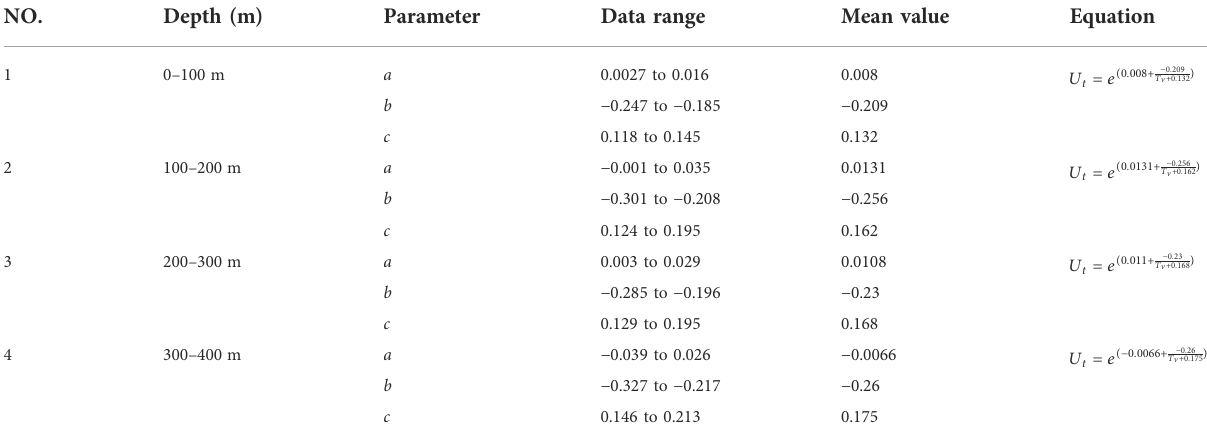
TABLE 3 The estimated parameters a , b and c for the CE_NCP consolidation